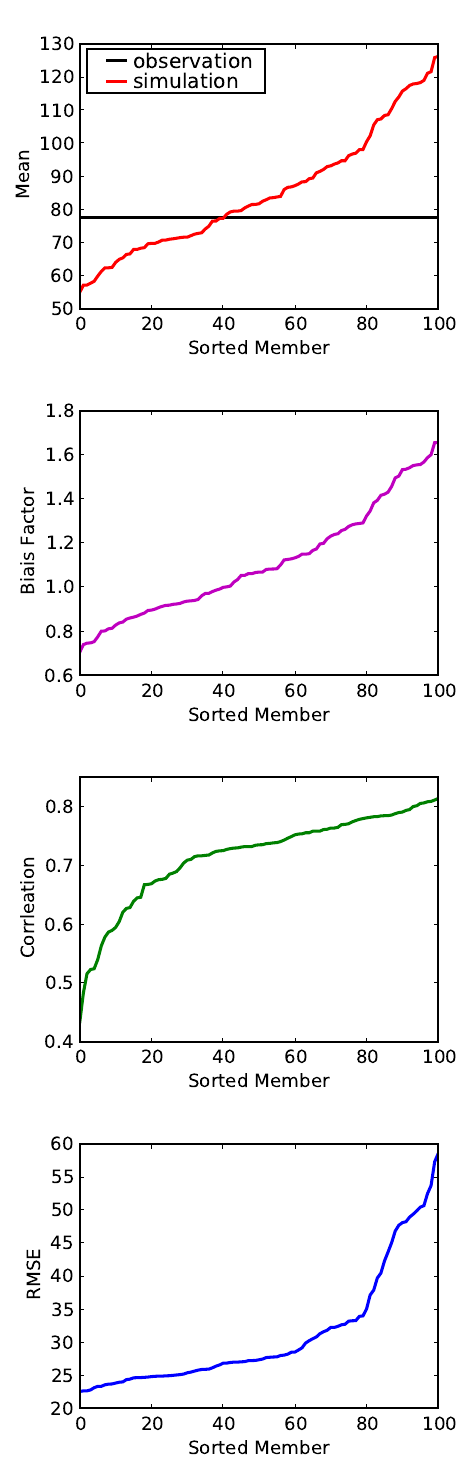
Fig. 3. Mean (µgm − 3 ), biais factor, correlation and RMSE (µgm − 3 ) for ozone peaks on network 1. In each plot, the models Fig. 3. Mean ( µ g m − 3 ), biais factor, correlation and RMSE are sorted according to the ( µ g m − 3 ) for ozone peaks on network 1. In each plot, the mod- els are sorted according to the indicator.